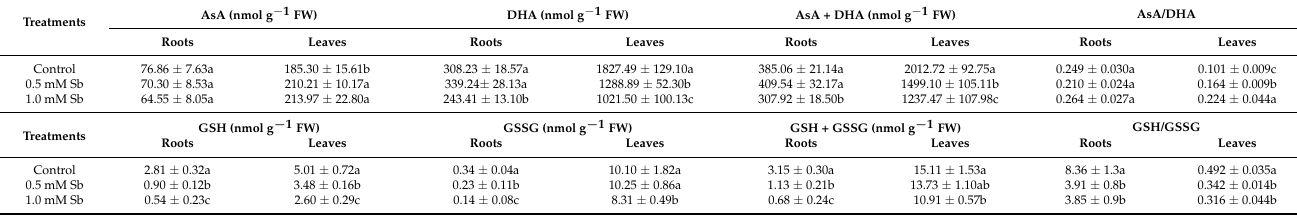
Table 5. Effect of Sb on the AsA, DHA, and ascorbate pool (AsA+DHA) contents and the AsA/DHA ratio, the GSH, GSSG, and glutathione pool (GSH+GSSG) contents and the GSH/GSSG ratio, in D. viscosa . The data are from 10 independent experiments, each carried out in triplicate (different letters indicate significant differences at p < 0.05, Mann–Whitney